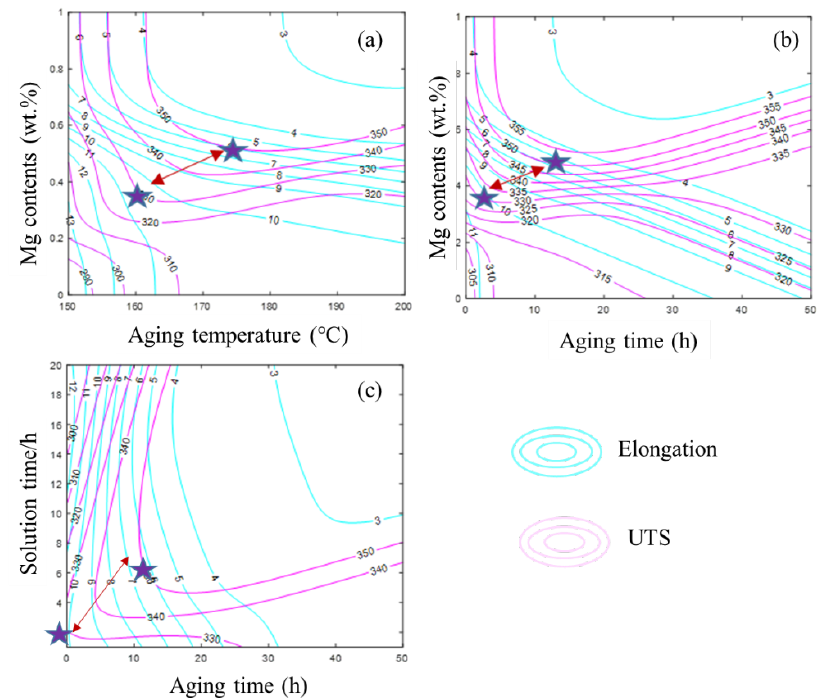
Figure 9. Isograms of UTS and elongation of Al–7Si alloy with different parameters: ( a ) Mg contents and Aging temperature; ( b ) Mg contents and Aging time and ( c ) Solution time and Aging time.